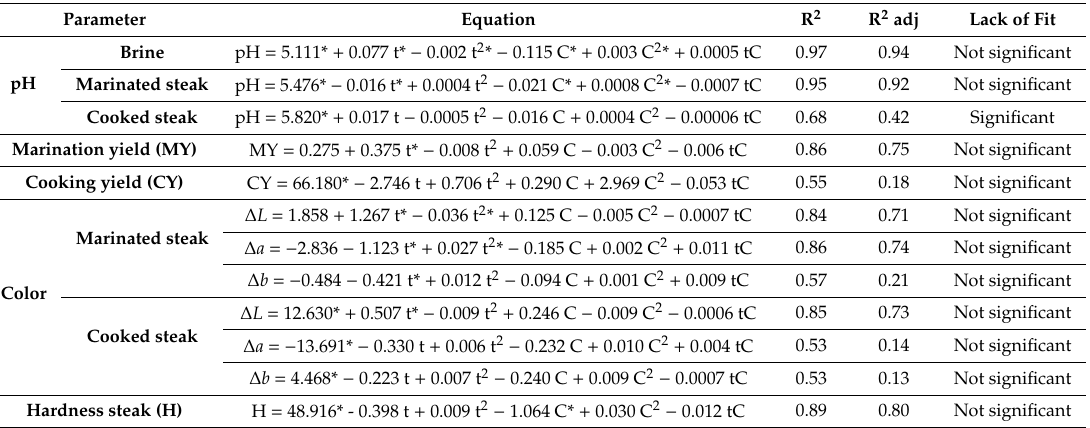
Table 2. Regression coe ffi cients of second-order polynomial equations for each response variable: pH of brine, marinated steak, cooked steak; marination yield (MY); cooking yield (CY); color of marinade and cooked steak; and hardness (H).